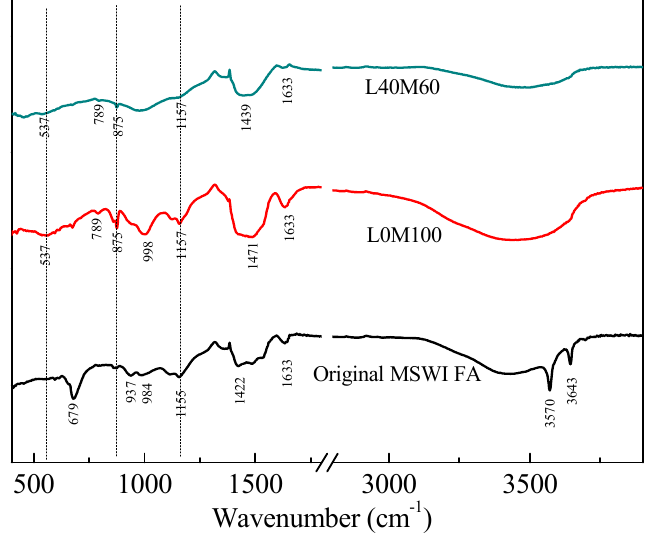
Figure 3. FTIR patterns of the original MSWI FA and geopolymer matrices.